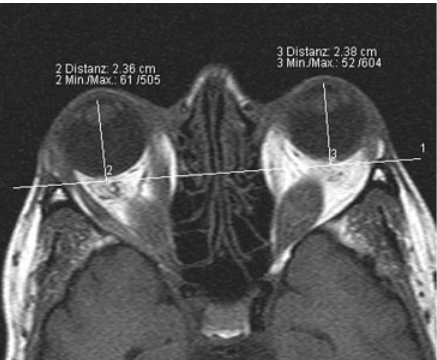
TransverseT1-w spin echo sequence without fat-saturation to define the amount of exophthalmos. Representative image from the standardized imaging protocol in a female patient (W.H., 1948) with active Graves’ orbitopathy. Dis- tances (No. 2, 3) from the apex of cornea to the interzygo- matic line (No. 1) given as Hertel- index: right 23.6 mm; left: 23.8 mm.